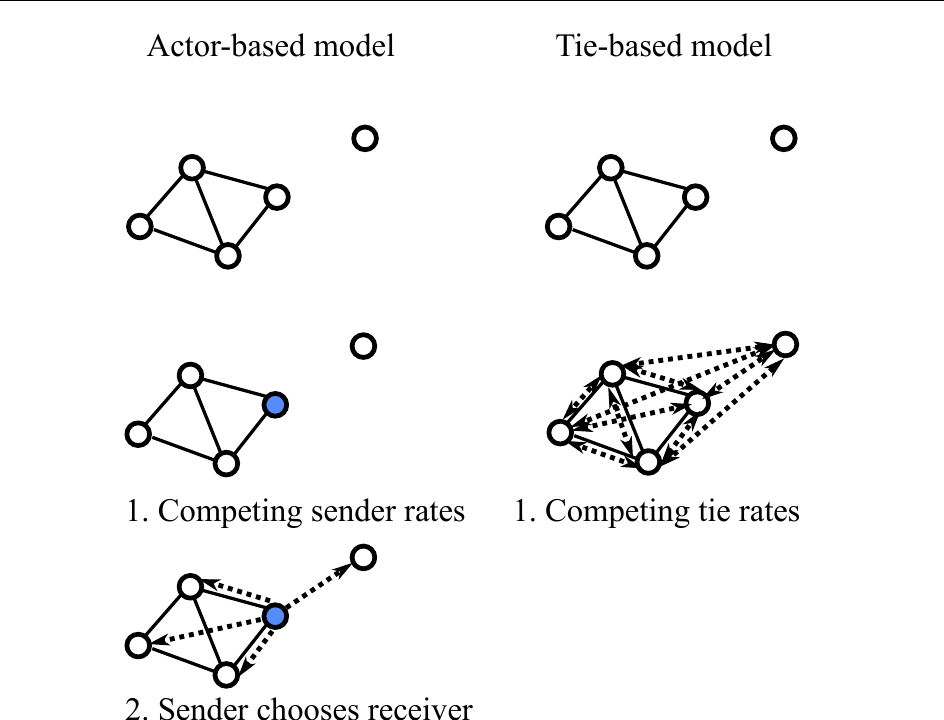
Figure 3: Comparison of actor-oriented and tie-oriented